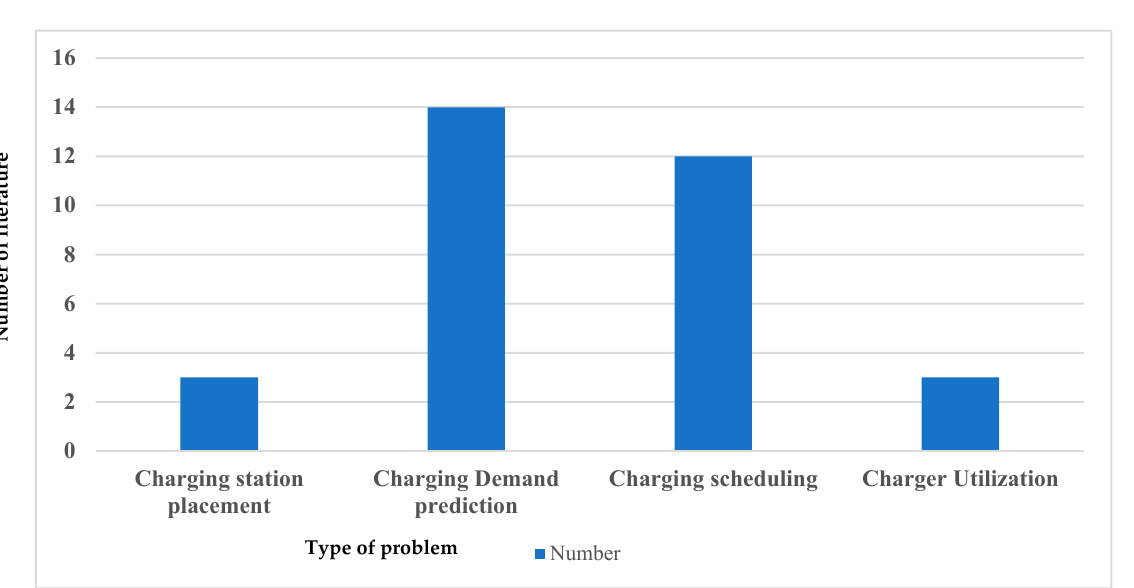
Figure 3. Quantitative analysis of the reported literature.